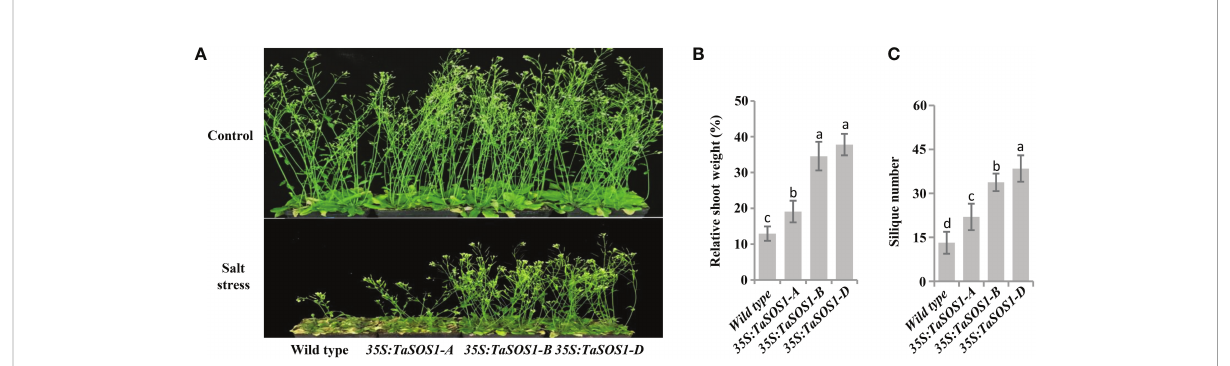
FIGURE 7 Comparison of 5-week-old of the wild type, the 35S:TaSOS1-A, 35S:TaSOS1-B and 35S:TaSOS1-D plants treated with 200 mM NaCl. (A) Five- day-old seedlings were transferred from MS medium to soil. The plants were then irrigated under well-watered conditions (Control) or irrigated every 5 d with 200 mM NaCl solution; 30 d later, phenotypes were measured and photographed. (B) and (C) Shoots fresh weight and silique number were measured relative to the same genotype grown on control condition. More than 24 plants were measured for each genotype. The values are means ( ± SE) of three biological replicates. The data were analyzed by ANOVA one-way comparison followed by LSD test. Different letters above the bars indicate a signi fi cant difference at P <